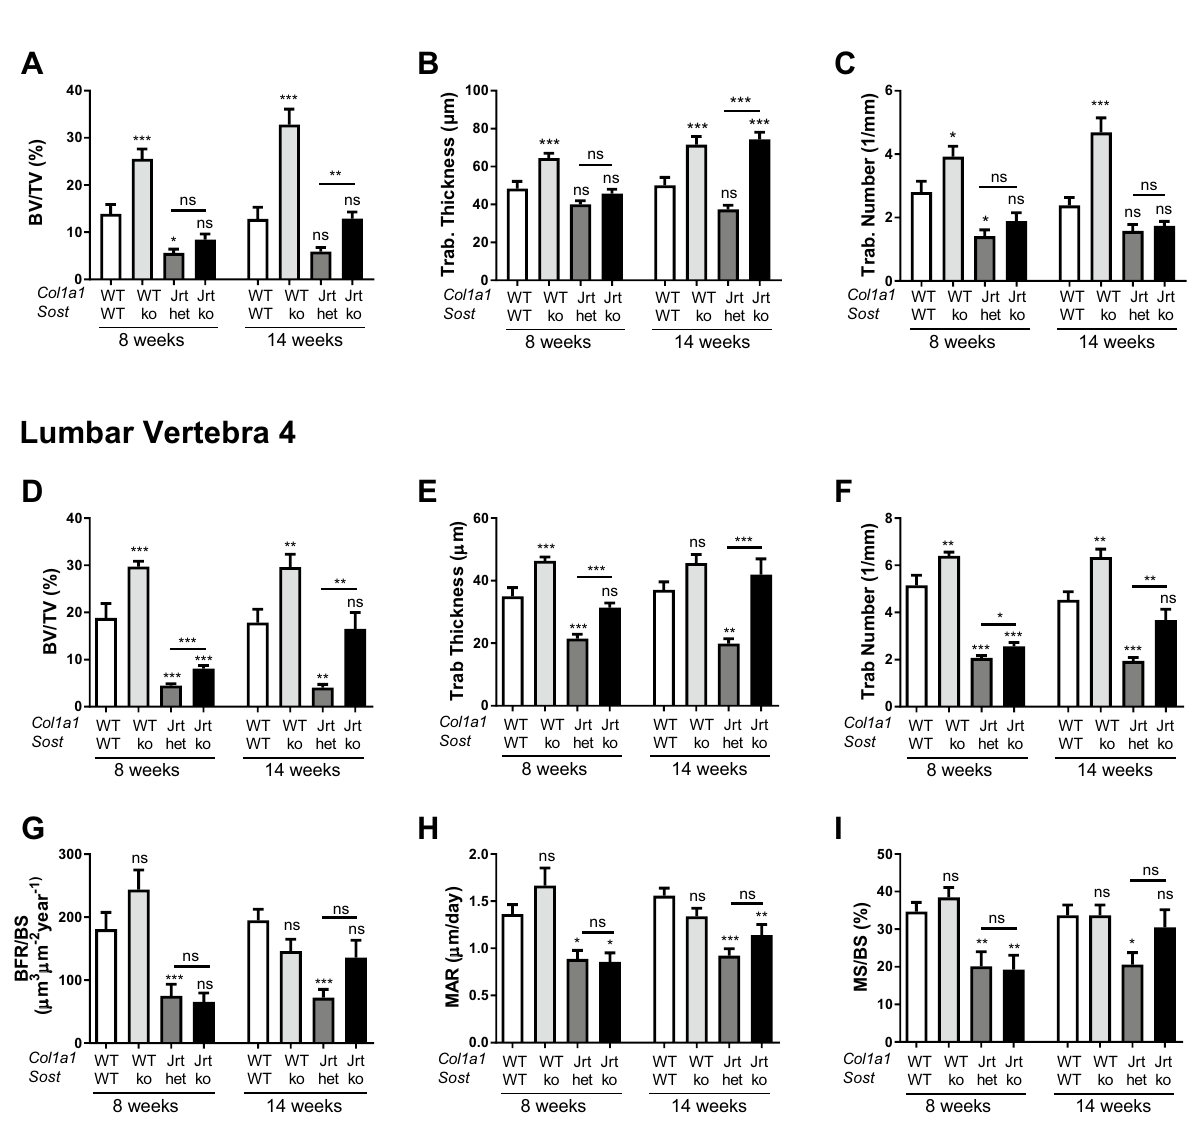
Figure 3. Trabecular bone characterization. Trabecular bone analyses at the distal femur ( A – C by microCT) and at lumbar vertebra 4 ( D – I by histomorphometry). Error bars represent standard errors. Significance levels for differences to WT mice (ANOVA) are indicated above each bar: * p < 0.05, **p < 0.01, ***p < 0.001, ns: not significant (p ≥ 0.05). Significance levels for differences between Jrt;Sost-het and Jrt;Sost-ko are indicated above the horizontal lines. n = 6–12 mice per group for femur analyses and 11–15 mice per group for vertebra